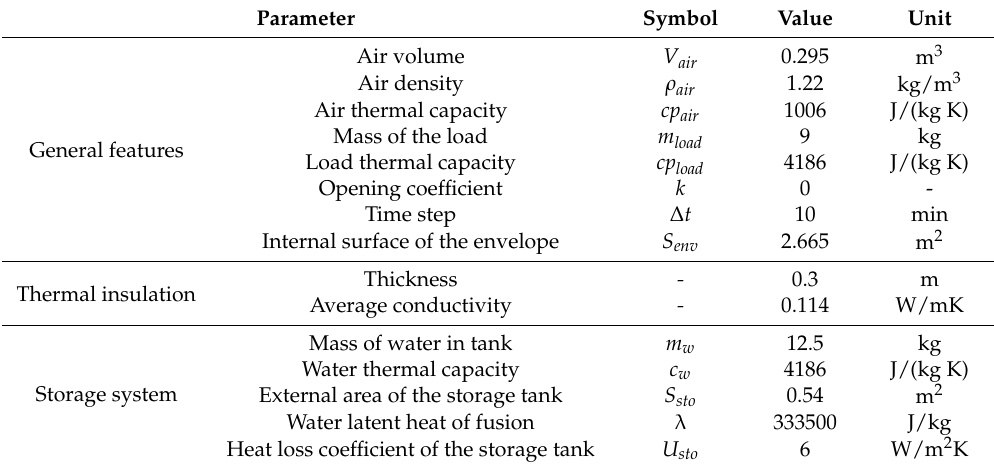
Table 3. Main reference parameters of the testing conditions.